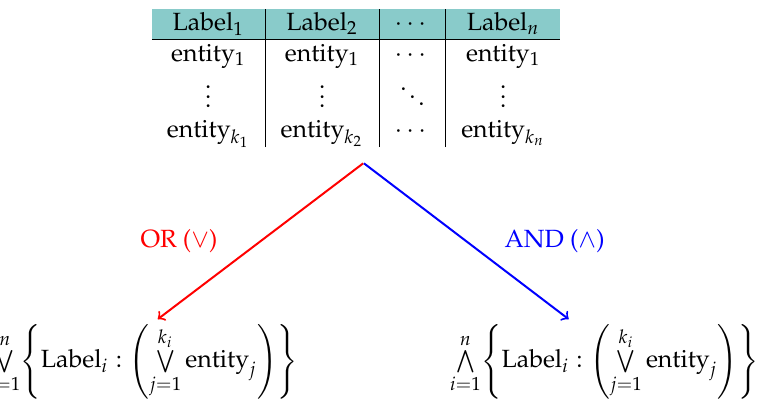
Figure 8. Graphical representation of the AND and OR queries; from a set of selected entities, arranged by their label.